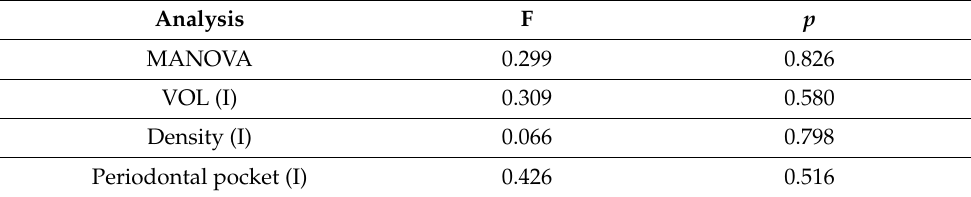
Table 3. Significance of the difference between the groups, in regard to the monitored parameters in the I measurement. Analysis F p MANOVA 0.299 0.826 VOL (I) 0.309